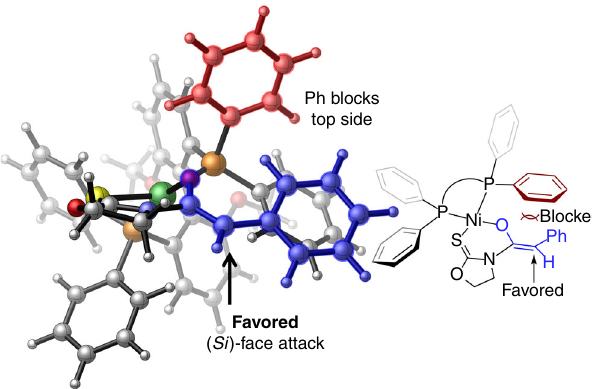
Fig. 8 Stereochemical induction model with chiral Ni-bound Z -enolate. The geometry was optimized at the B3LYP/LANL2DZ – 6 – 31G(d)